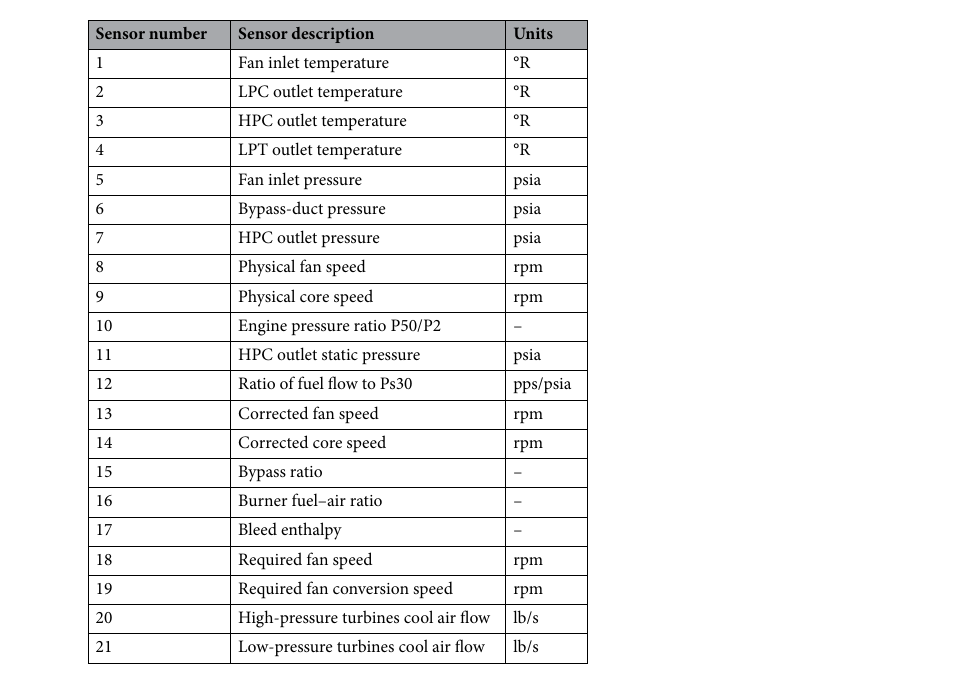
Table 1. Data description of turbofan engine